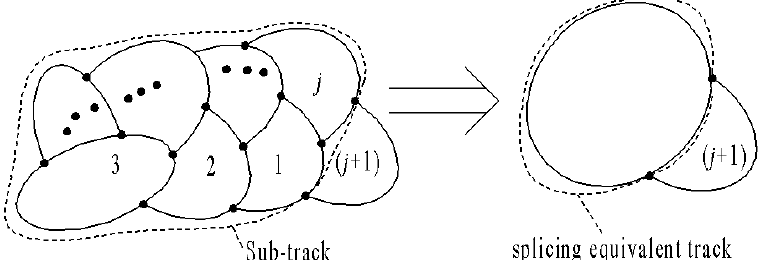
Figure 2. Diagram of the mechanism of track splicing.